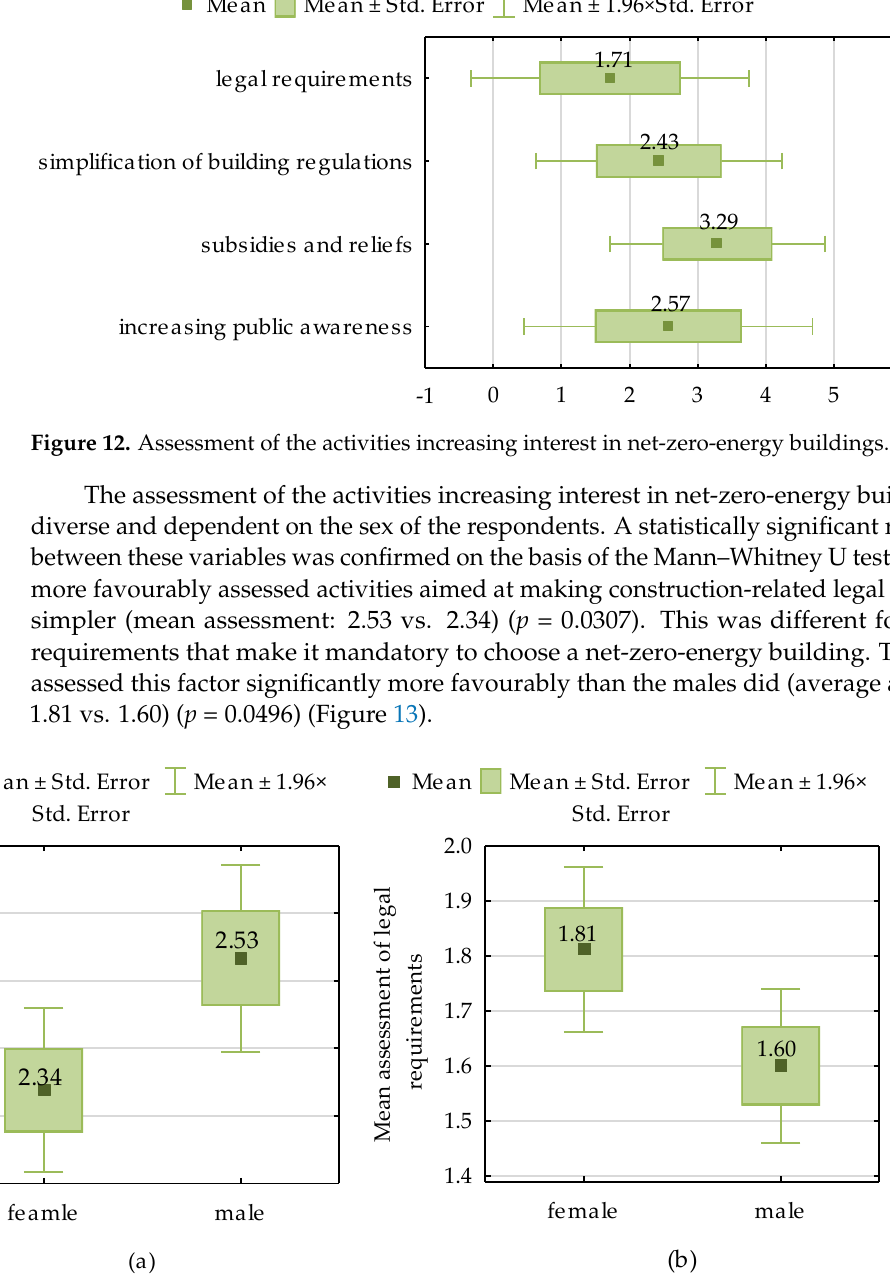
Figure 13. Diversity of the assessment of activities increasing interest in net-zero-energy buildings in terms of sex in the scope of ( a ) simplifying building regulations, ( b ) legal requirements to choose net-zero energy buildings.